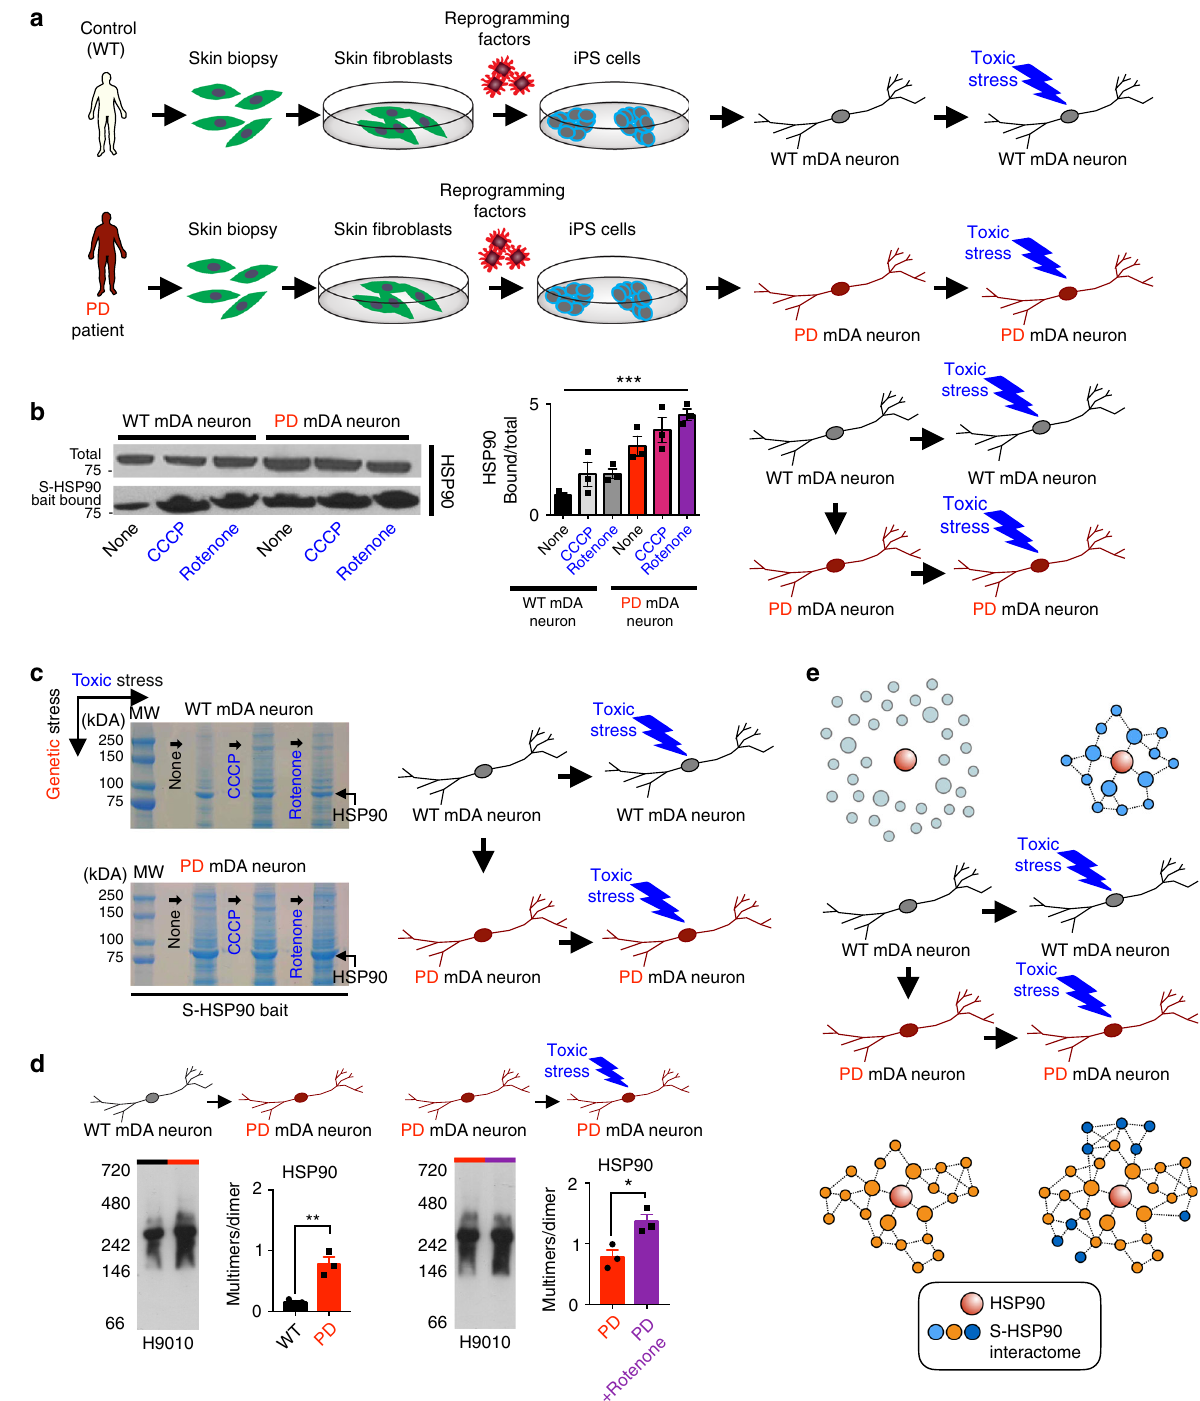
Fig. 2 PD-relevant stresses recon fi gure the chaperome into stable chaperome networks. a Schematic illustration of the overall experimental design showing the application of toxic and genetic PD stresses. b Western blot of total HSP90 and of S-HSP90 in mDA neurons upon genetic ( Parkin defect) and toxin treatments (10 µ M CCCP; 20 nM rotenone), alone or combined. Mean ± SEM, n = 3 individual values from the different experiments shown as points, One- way ANOVA, *** p < 0.001. c Coomassie stained denaturing gel (example of a gel submitted for proteomics analyses, n = 3 WT, n = 2 WT + CCCP, n = 2 WT + rotenone, n = 3 PD, n = 3 PD + CCCP, n = 3 PD + rotenone, where each n is a different experiment) showing the S-HSP90 and its interactome, as af fi nity-puri fi ed by the PU-H71 bait. d Native-PAGE shows S-HSP90 formation under PD stress, as indicated by an increase in stable HSP90 species over the dynamic HSP90 dimer. Mean ± SEM, n = 3 individual values from the different experiments shown as points, t -test, ** p < 0.01; * p < 0.05. e Summary schematic showing how in mDA neurons genetic and toxic stresses induce chaperome network assembly, executed by an increase in the association strength between the participant